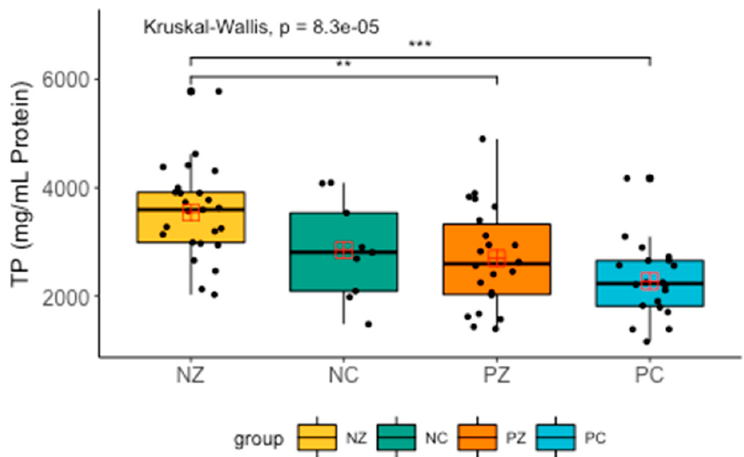
Figure 11. Levels of total protein in the saliva of the examined women. TP, total protein; NZ, generally healthy patients without the BRCA1 mutation; NC, patients with breast cancer but without the BRCA1 mutation; PZ, generally healthy patients with the BRCA1 mutation; PC, patients with both breast cancer and the BRCA1 mutation. ** p < 0.01; *** p < 0.001. The strongest positive correlation was found between TOS and OSI (r = 0.95, p < 0.00001). The strongest negative correlation was found between TP and Px (r = − 0.86, p < 0.00001) (Figure 12).